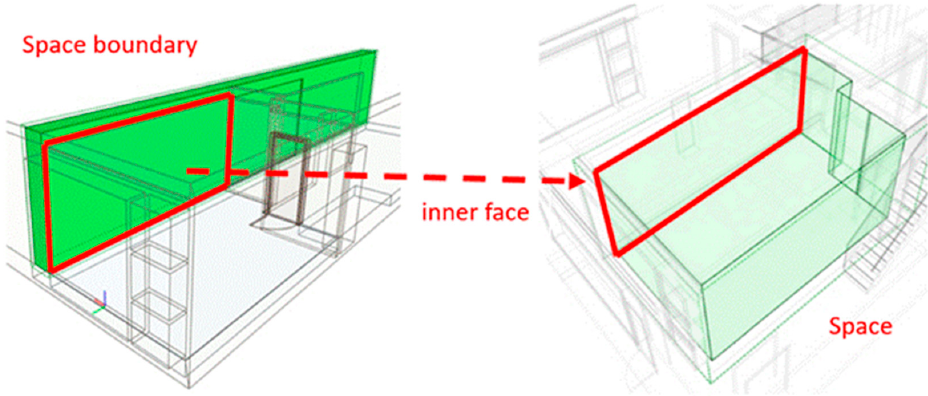
Figure 3. A boundary and representation of an instance of the IfcSpace